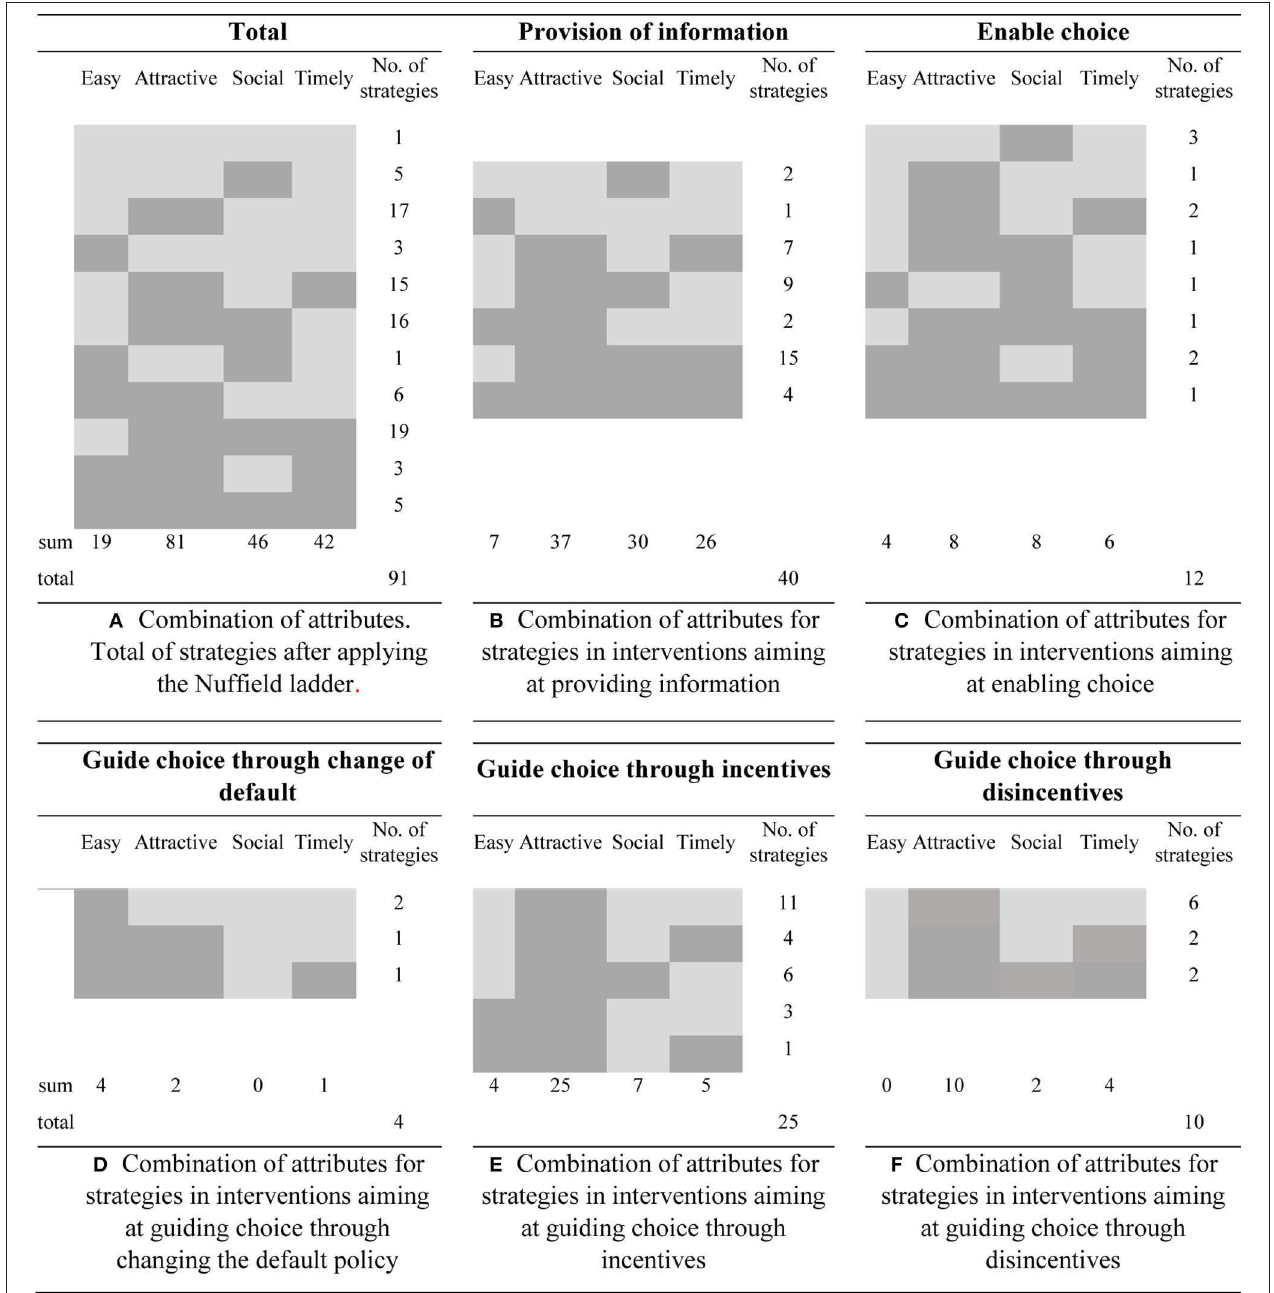
FIGURE 3 | Combinations of attributes according to the EAST (Easy, Attractive, Social, and Timely) classification (dark gray) of strategies aimed at influencing behavior in the implementation of animal health activities. The results are shown as total and divided into the five lowest steps in the Nuffield ladder: total (A) ; provision of information (B) ; enable choice (C) ; guide choice through change of default (D) ; guide choice through incentives (E) ; guide choice through disincentives (F)